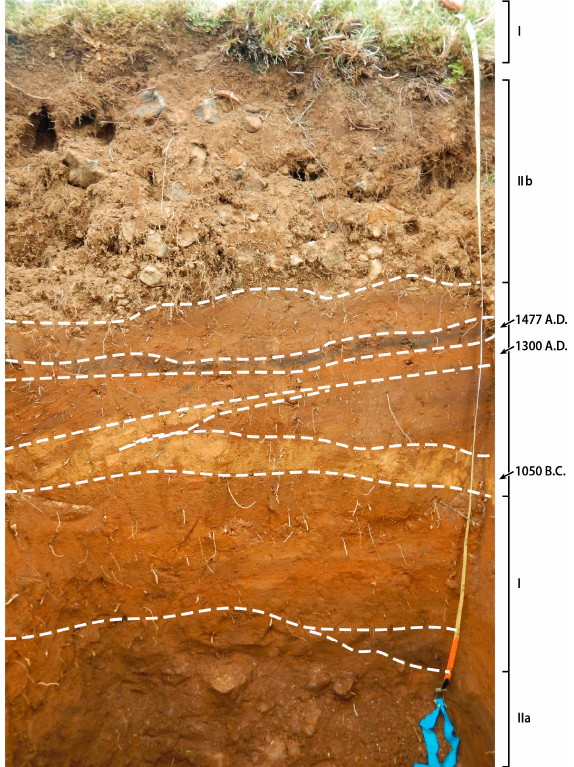
Figure 6. Stratigraphical section S19 at the edge of Flautafell’s western homefield wall. Slope deposits (Facies IIa and Facies IIb) are separated by fine sediments (Facies I) with dark- and light-colored tephras. The scale on the right (tape measure) is one meter.